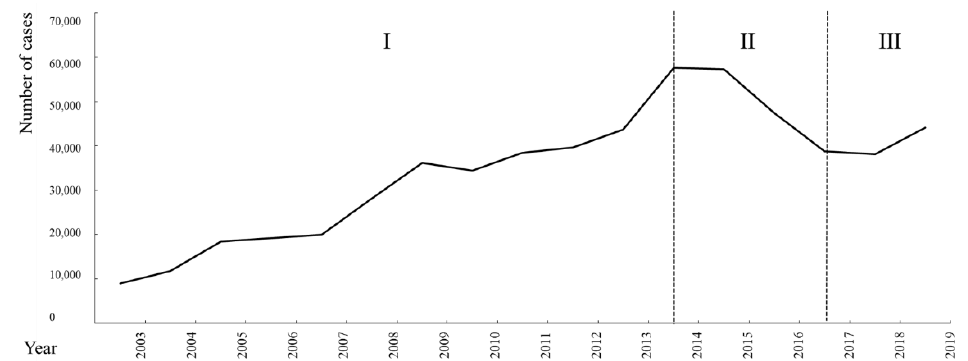
Figure 1. Number of new cases of Brucellosis in China during 2003 – 2019.